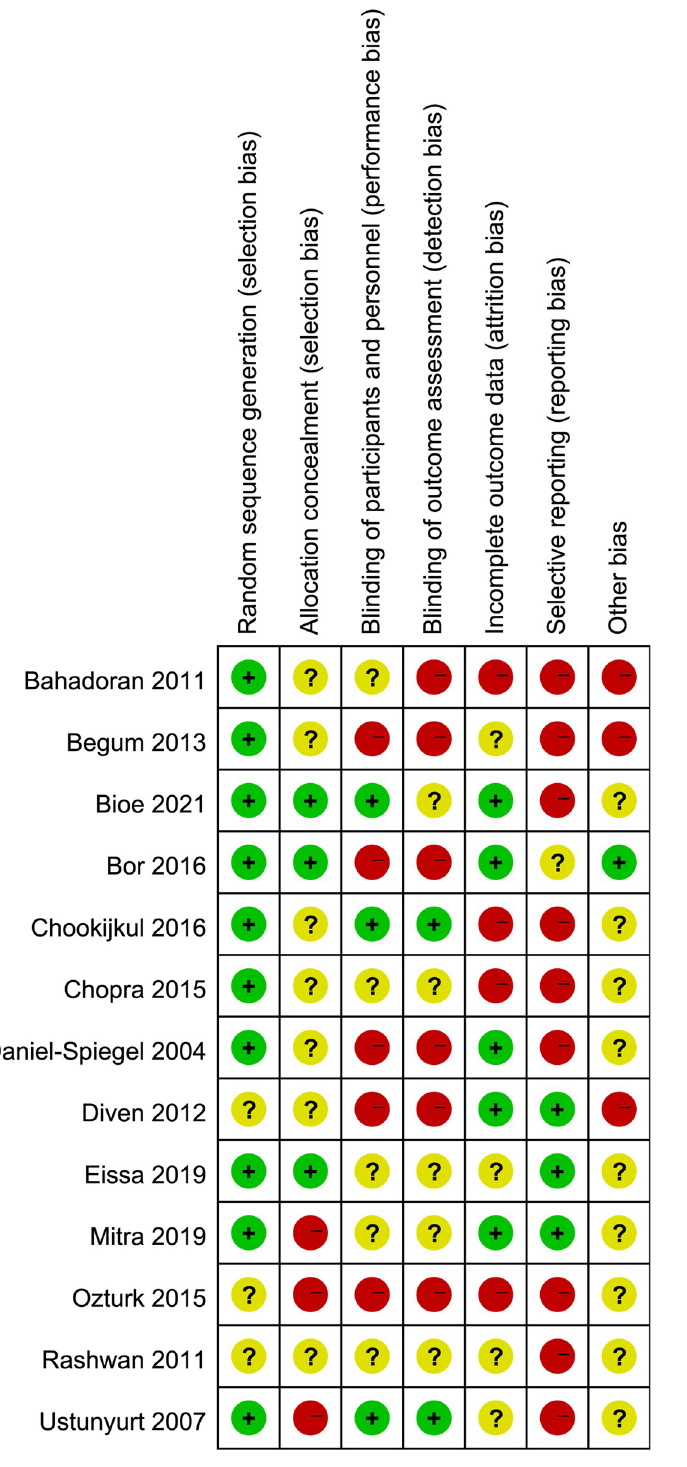
Fig 3. Risk of bias